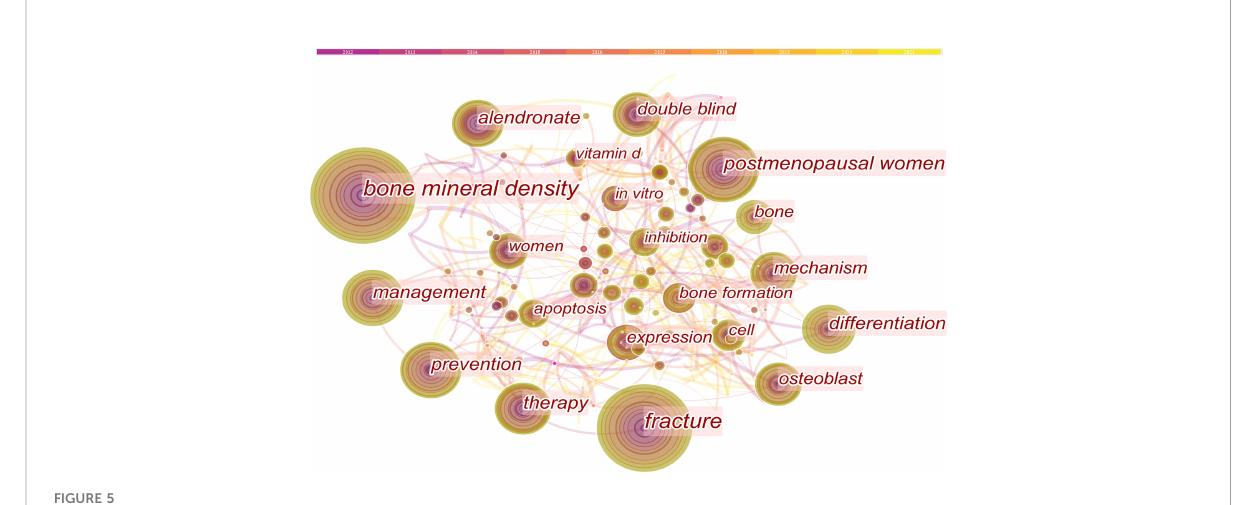
FIGURE 5 Co-occurring keywords